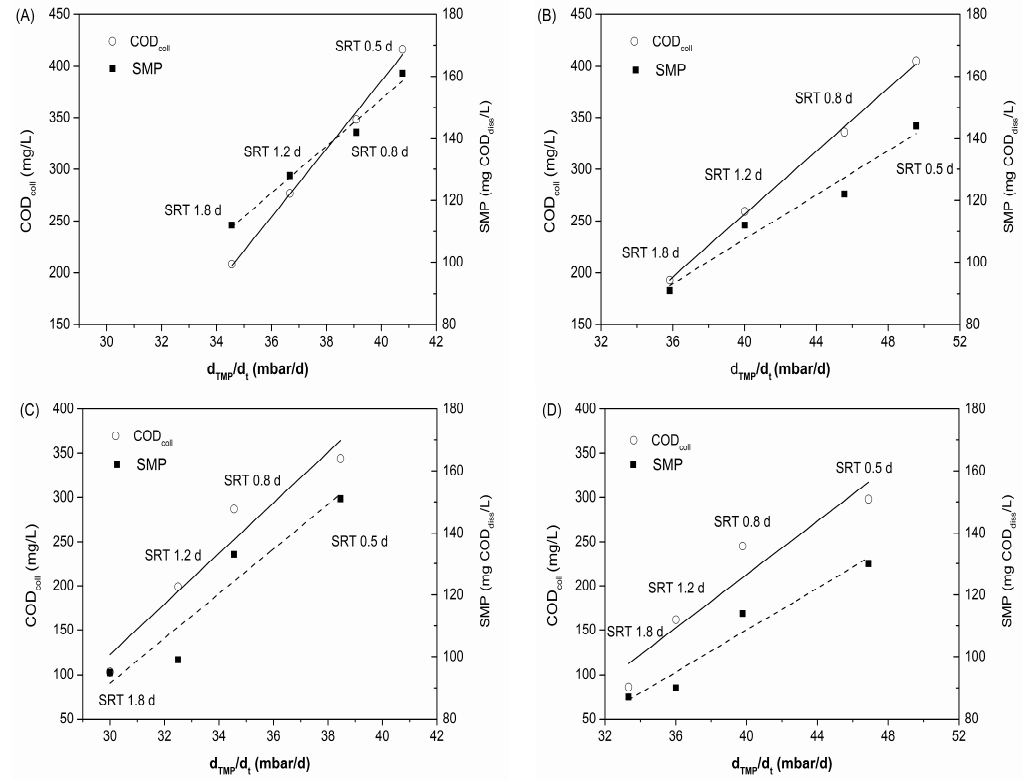
Figure 8. Effects of averaged concentrations for the COD coll and soluble microbial products (SMP) at different SRTs on transmembrane pressure (TMP) increase rates of ( A , B ) HL-MBR and ( C , D ) HRCS-MBR. ( A , C ) demonstrate the TMP increase rates of the physical cleaning cycle for both MBRs, whereas ( B , D ) are the TMP increase rates during the chemical cleaning cycle in each SRT. Table 3. Pearson’s correlation coefficient ( r p ) and p -values for linear correlations between transmembrane pressure (TMP) increase rate and concentrations of the colloidal fraction (COD coll ) and soluble microbial products (SMP). d TMP /d t r